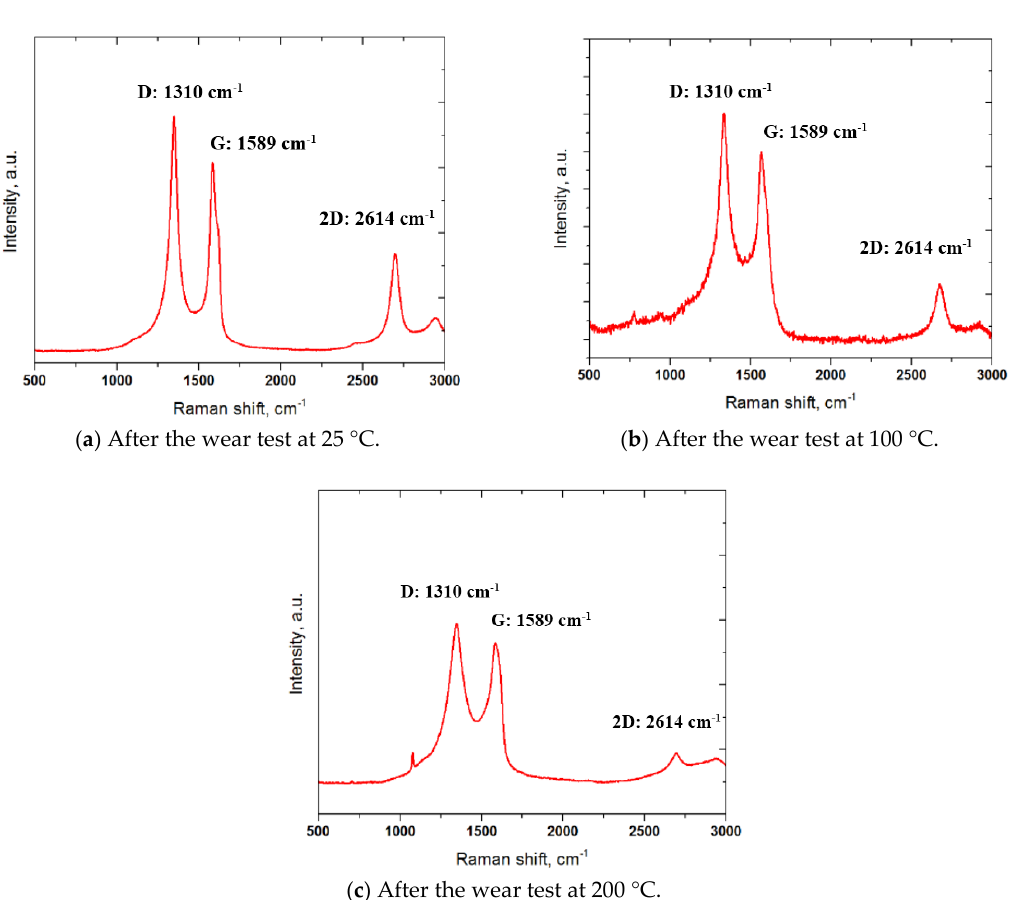
Figure 12. Wear volume of AISI52100 steel ball slid against the C/C-SiC composite at temperatures of 25, 100 and 200 °C.